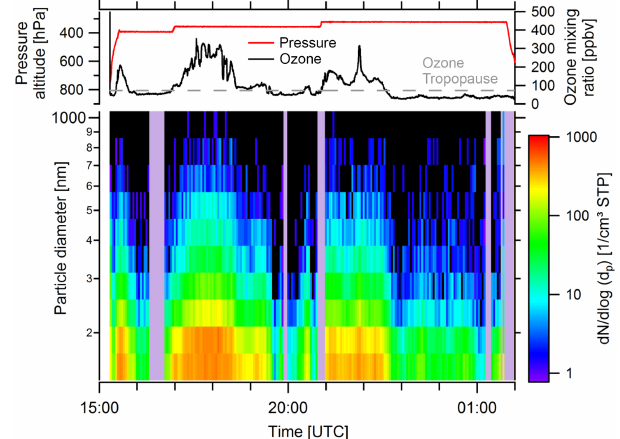
Figure 14. Accumulation mode particle number size distribution for the CARIBIC flight LH319 from Frankfurt, Germany, to Bo- gota, Columbia, on 16 November 2010. This flight is characterized by alternating tropospheric and stratospheric flight sections (see ozone mixing ratio and www.knmi.nl/samenw/campaign_support/ CARIBIC/161110/index.html, accessed 1 July 2015). Same repre- sentation as in Fig.